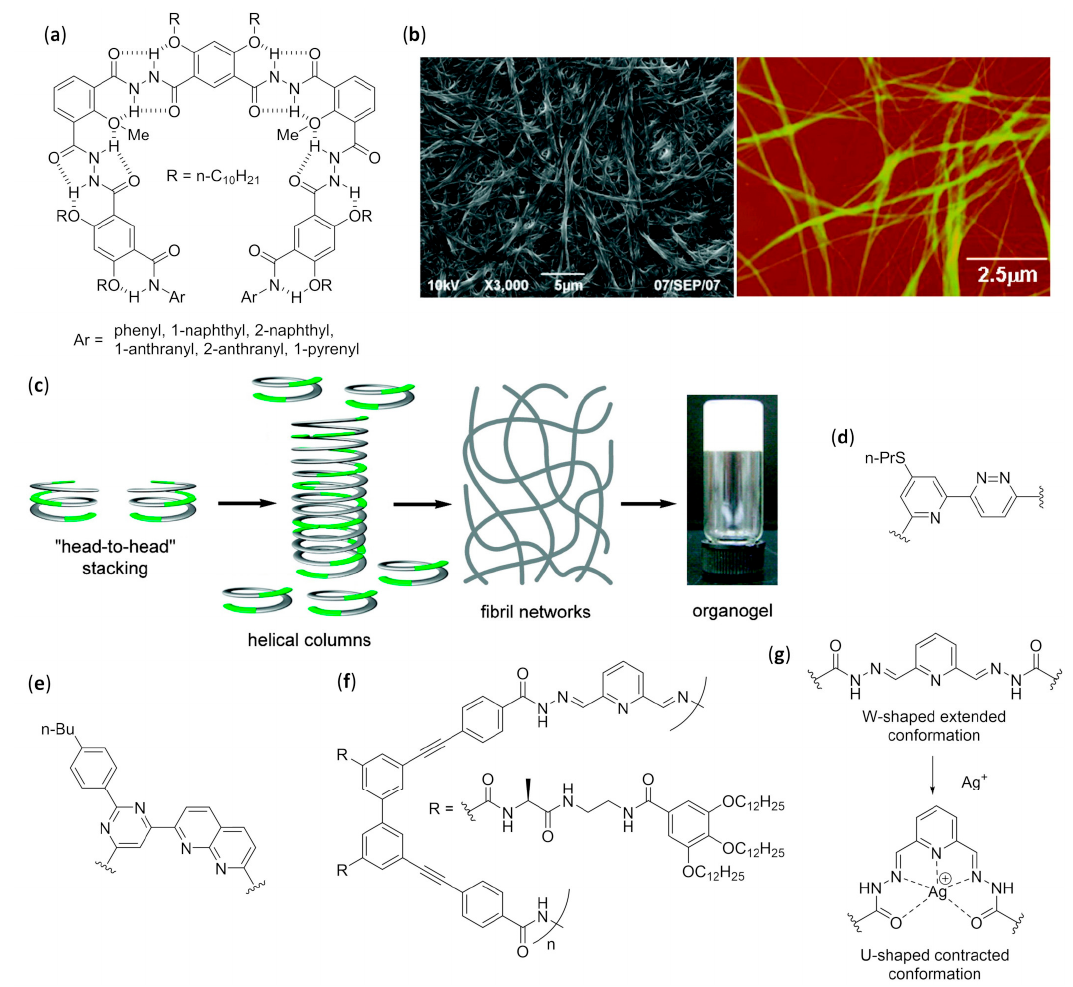
Figure 17. ( a ) General structures of aromatic hydrazide foldamers studied (Refs. [174,183]); ( b ) Representative SEM and AFM images of dried gels obtained from 0.1 mM solutions of a selected hydrazide foldamer in (left) n -octanol and (right) toluene (adapted with permission from Ref. [183]); ( c ) Representation of the gelation process induced by hydrazide foldamers (hydrazide strand in gray, appended arene units in green, decyl side chains omitted for clarity): the head-to-head stacking of foldamers gives rise to long columnar alignments, which in turn form bundles and then the gelating fibrils by interdigitation of alkyl side chains (adapted with permission from Ref. [183]); ( d ) Pyridine– pyridazine alternating units in the transoid conformation (Refs. [185–187]); ( e ) Naphthyridine– pyrimidine alternating units in the transoid conformation (Refs. [188,189]); ( f ) General structure of conformationally switchable foldamers and ( g ) their Ag + coordination-driven conformational switch (Ref.